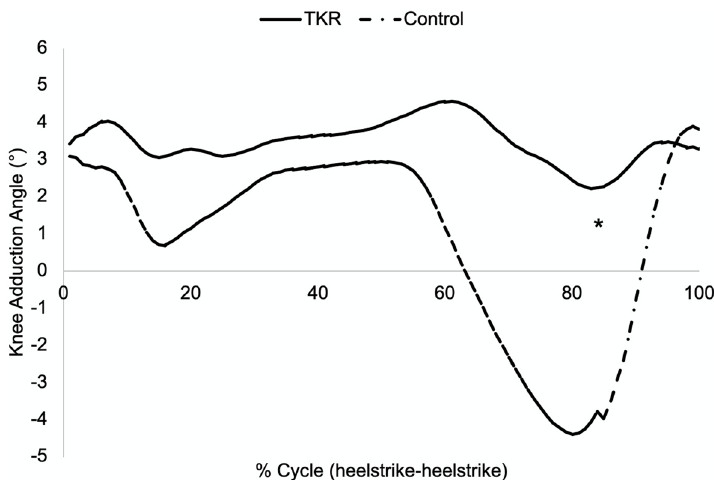
Fig. 2 Analysis of the knee adduction angle (KAA) during the swing phase of gait. The bi-cruciate substituting PS TKA group showed less knee adduction angle excursion (peak-to-peak) compared to healthy controls